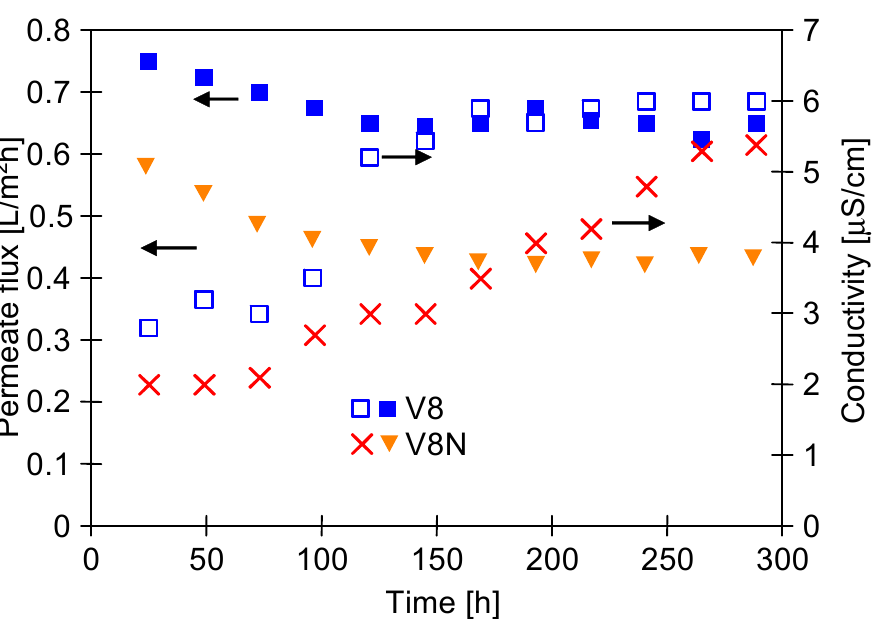
Figure 7. Changes in the permeate flux and conductivity of the distillate during MD realized in a two-chamber MDC installation. Feed: saturated NaCl solution contaminated with oil (85 mg/L). Modules M3 (V8) and M4 (V8N). Temperature T F = 328 K and T C = 310 K.